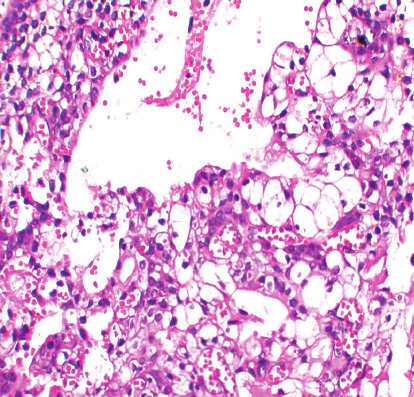
Figure 7: Mucous cells, epidermoid cells, and clear cells (H&E